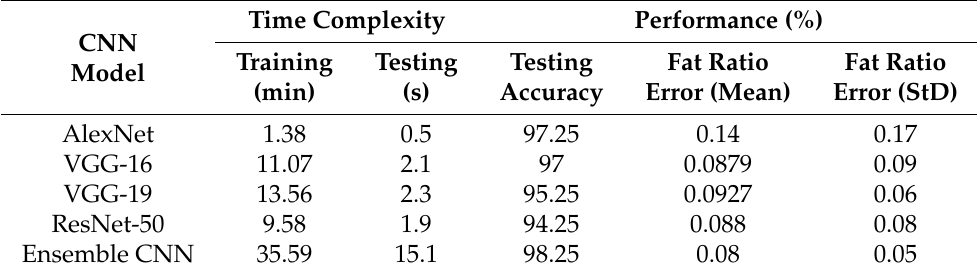
Table 7. Time complexity versus performance per CNN